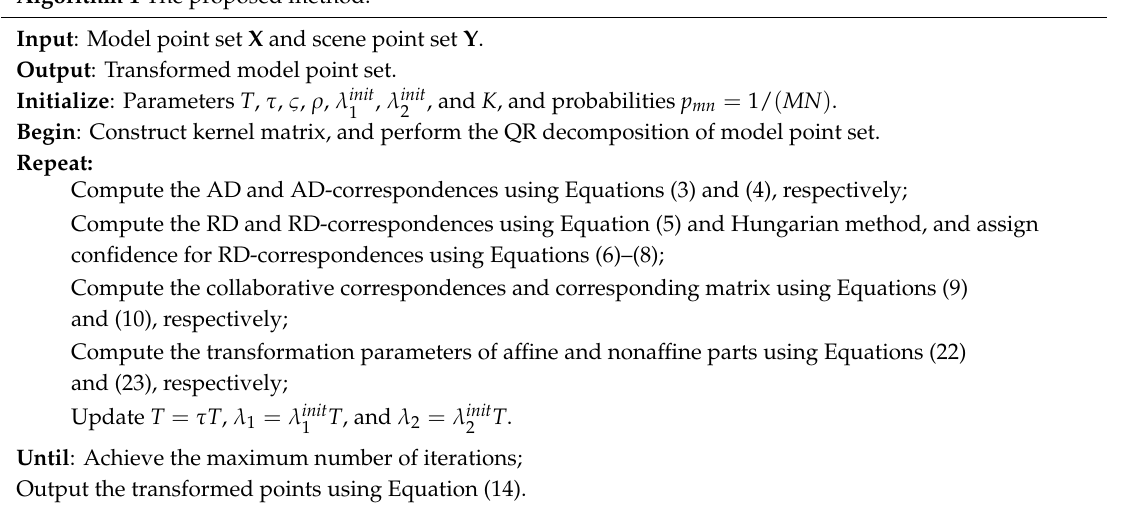
Algorithm 1 The proposed